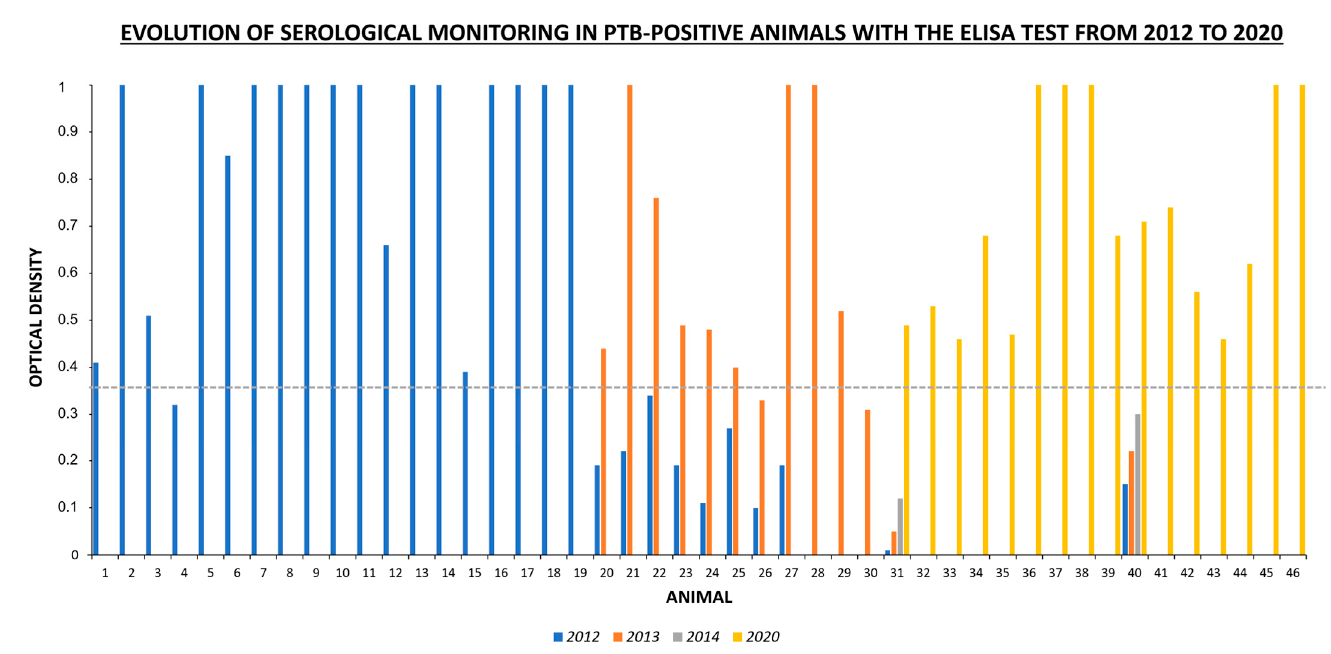
Figure 2. Optical density values with ELISA test in PTB-positive animals ( n = 46) and their evolution during the studied period. The dashed line indicates the cutoff point established by the ELISA technique (0.36). The animals were considered positive when their serological indices were higher than the cutoff point. The animals whose serological indices were below the cutoff point were monitored in subsequent checkups and were eliminated once they were positive. After the free status of PTB reached in 2014, the serological control from 2015 to 2019 was not performed until the reappearance of the disease in 2020.